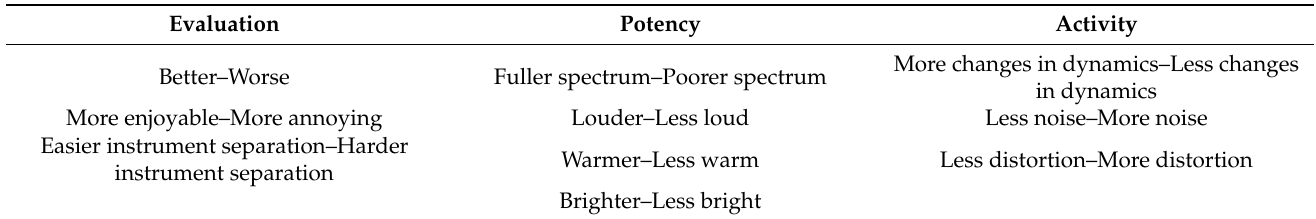
Table 2. Correspondence between factors (Evaluation, Potency, Activity) and the ten bipolar scales used in this study for the application of the semantic differential